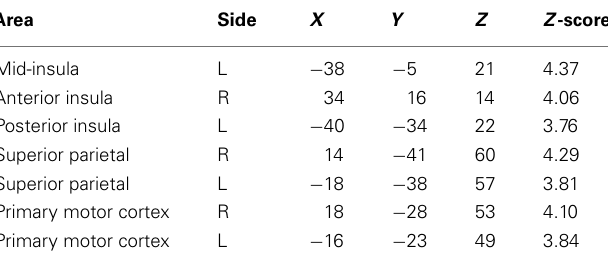
Table 1 |Activations reflecting the interaction between factors of “intentionality” and “causality” from the ROI